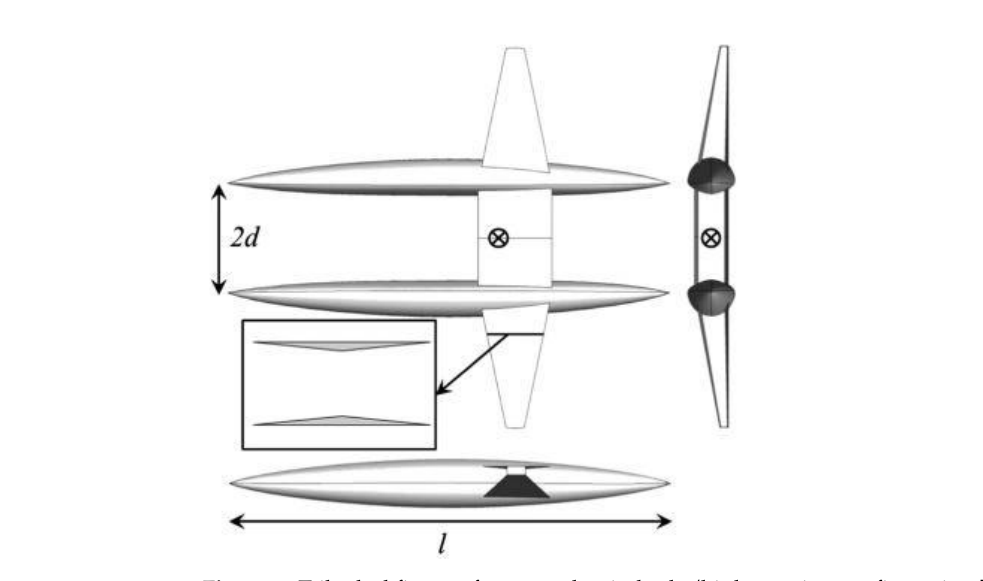
Figure 9. Trihedral figure of proposed twin-body/biplane-wing configuration [22]. After the two oblique shock waves generated at the leading edge of the wings intersect, they respectively propagate to the throat of the wings and interfere with the expansion wave generated here, so as to weaken the shock wave strength and reduce the shock wave drag. Pressure contours are as shown in Figure 10.